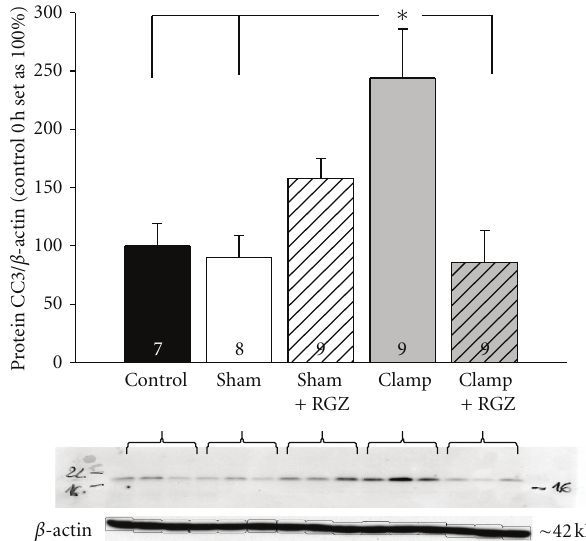
Figure 5: E ff ect of 5mg/kg rosiglitazone (RGZ) on the relative expression of cleaved caspase 3 (CC3) in renal cortex of Sprague- Dawley rats in renal I/R injury. Antibody against CC3 recognized a band in the range of 18 kDa; the anti- β -actin antibody recognized a band at 42 kDa. The amount of CC3 Western blot against CC3 and β -actin was performed as described in Section 2. Western blot signal was normalized to the respective signal from β -actin. ∗ Statistically significant di ff erence with P < 0 . 05; n as